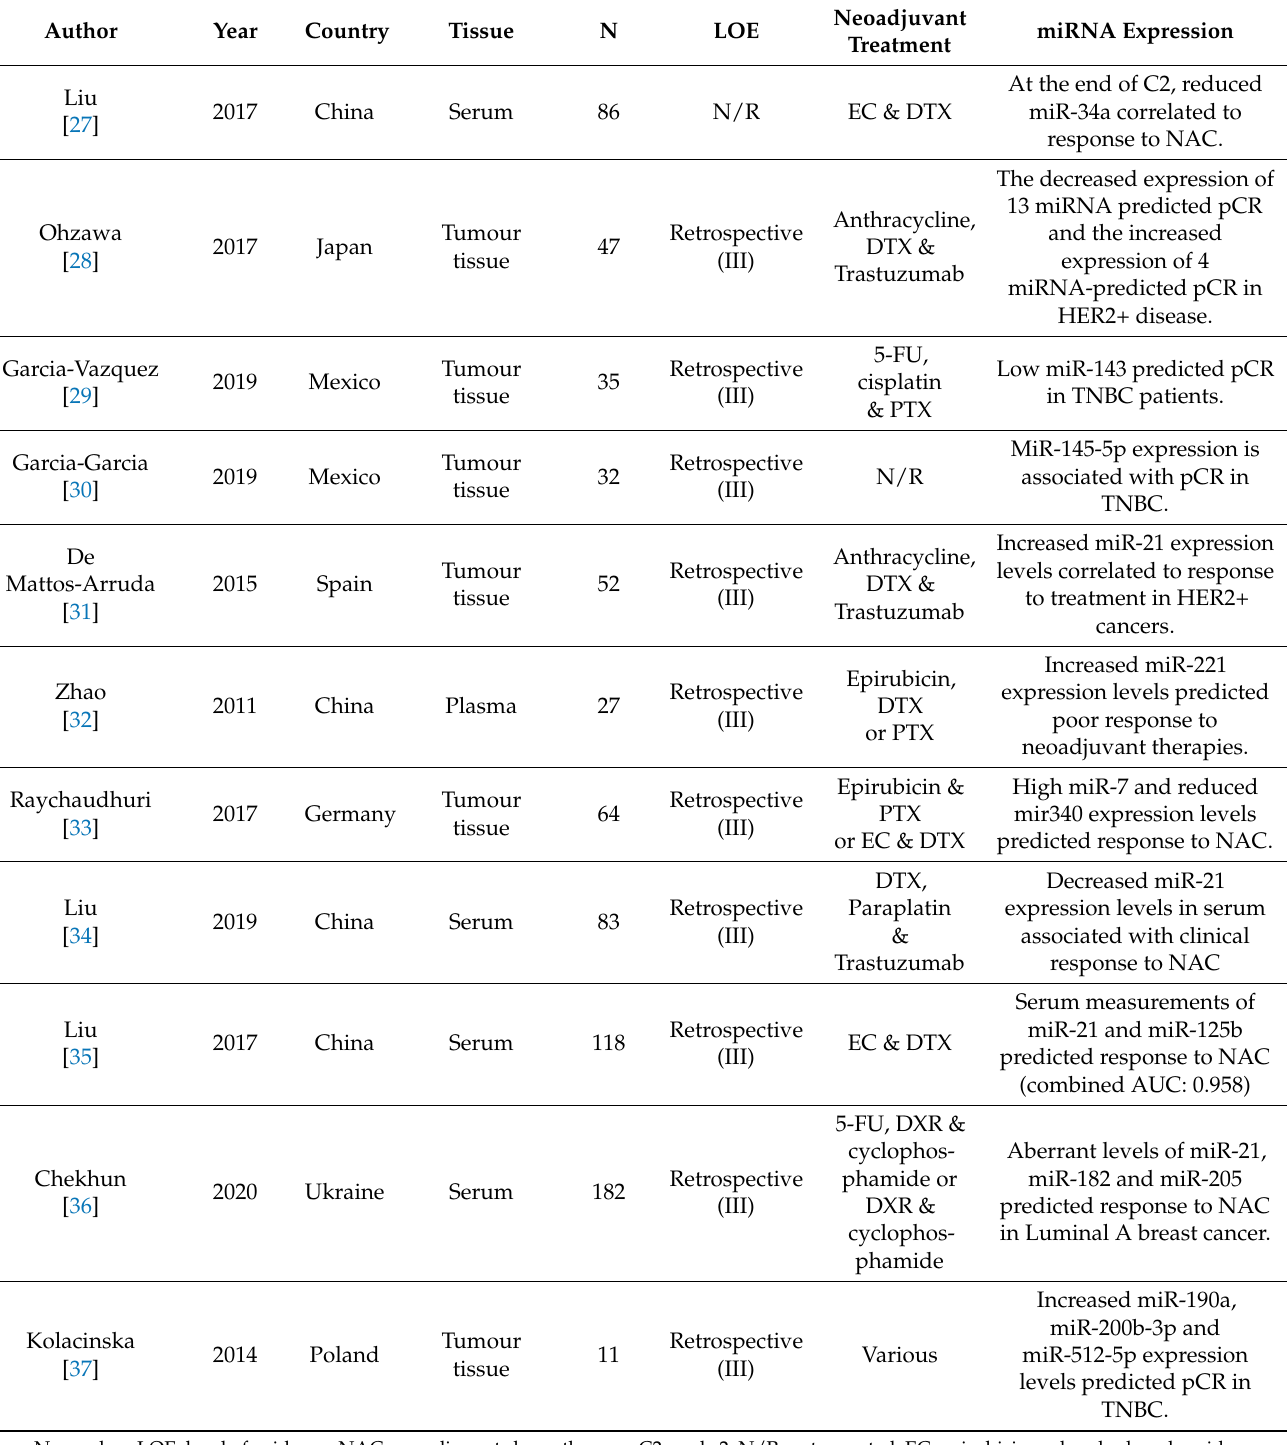
Table 1. Studies correlating microRNA (miRNA) expression profiles to response to neoadjuvant